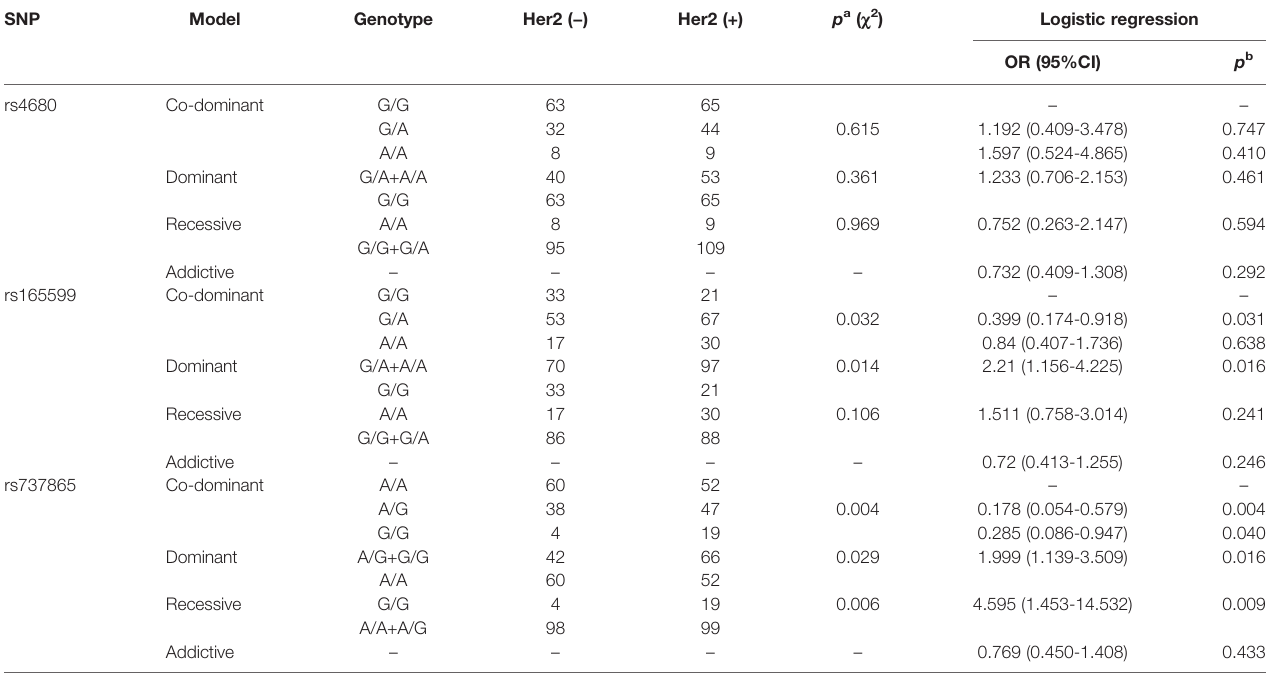
TABLE 5 | Genotype frequencies of SNPs of the COMT (rs4680, rs165599, and rs737865) genes between two groups. SNP Model